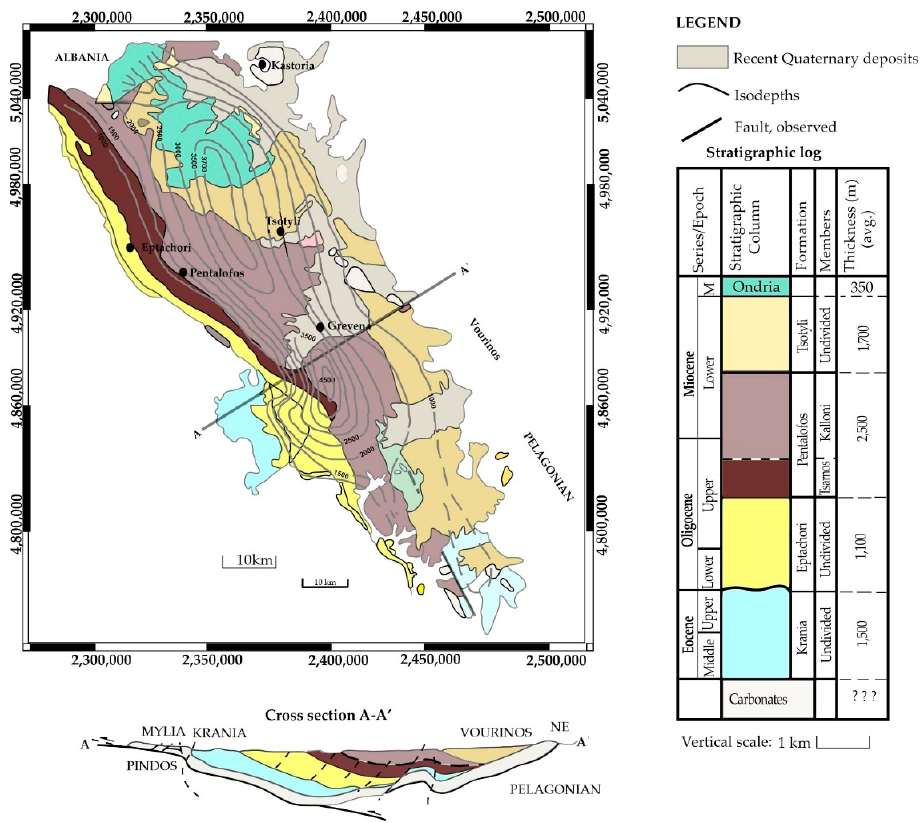
Figure 4. Geological Map and stratigraphic column adapted from Ferriere et al., 2004, of the proposed CO 2 Storage basins in Grevena area depicting Pentalofos and Eptachori formations, scale 1:1,000,000. Cross-sections of the Mesohellenic Trough. Lithological formations: Krania Turbidites, Eptachori, Taliaros, Pentalofos, Tsotyli. M stands for Middle Miocene, scale 1:500,000.